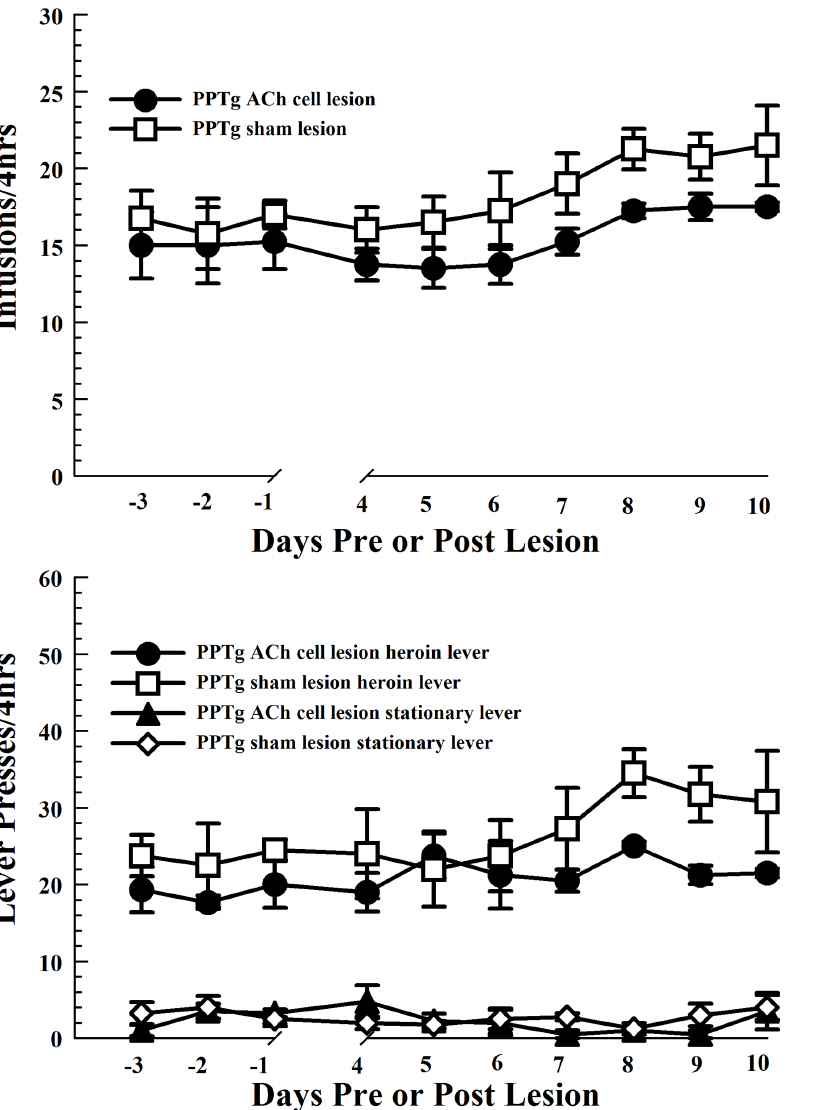
Figure 4. Intravenous self-administration of heroin is not altered by bilateral pedunculopontine tegmental nucleus (PPTg) cholinergic cell loss. Bilateral PPTg cholinergic cell lesions (solid circles; n=4) did not significantly affect heroin self-administration relative to sham lesions (open squares; n=4), either in terms of the number of heroin infusions in daily sessions (top) or the number of active lever presses to attain those infusions (bottom panel). All rats showed a slight increase in heroin intake across the post-lesion testing period. The ability to distinguish between the retractable heroin and stationary levers was not compromised by PPTg cholinergic cell loss. Error bars represent 6 SEM.